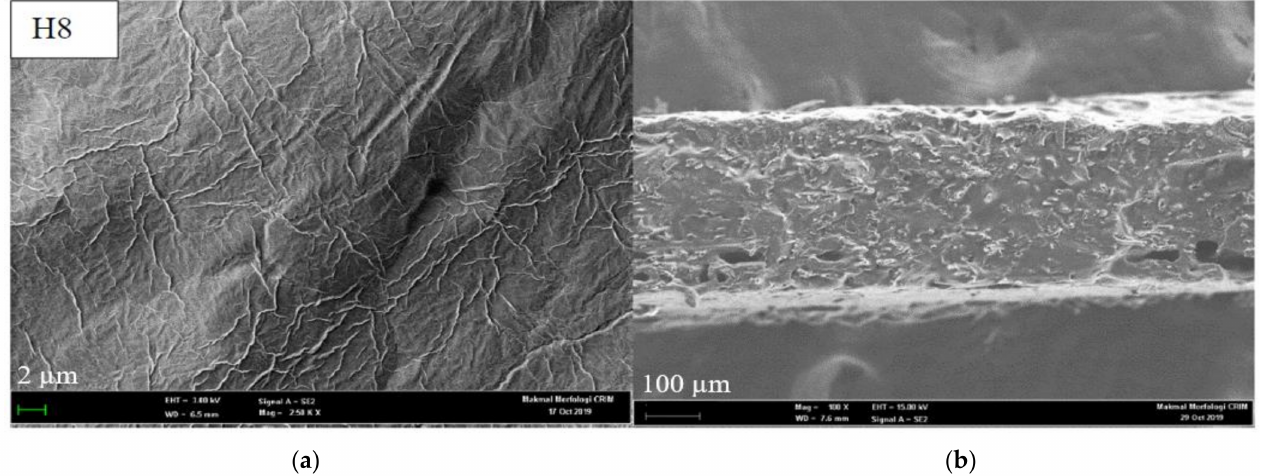
Figure 3. ( a ) Surface morphology and ( b ) cross-sectional view of thermo-responsive cellulose hydrogels at the magnification of 2.50k × and 100 × ,